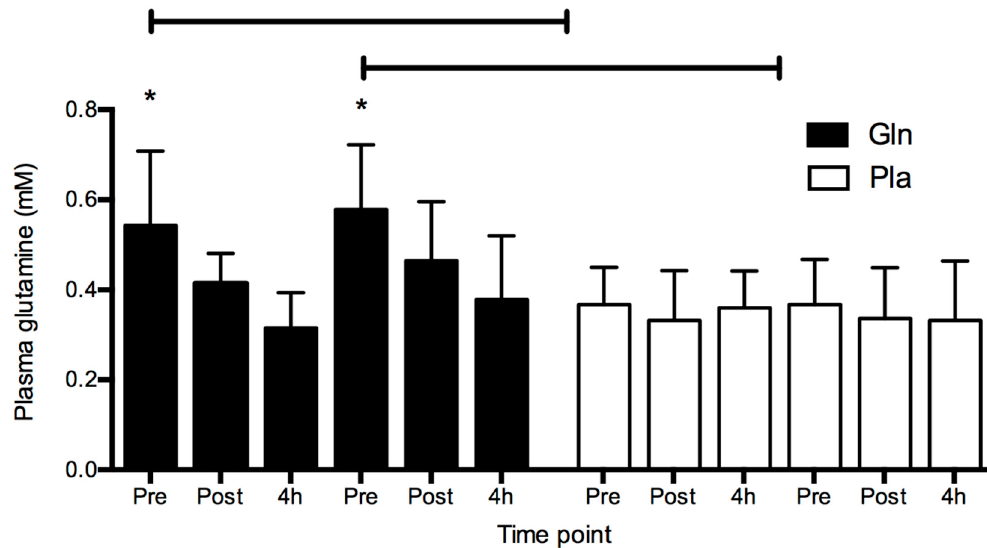
Figure 2. Plasma glutamine levels. Subjects ingested 0.075 g/kg of glutamine (Gln) or placebo (Pla) 1 hour prior to and after repeated exercise on consecutive days (Ex 1 = Day 1 and Ex 2 = Day 2). Plasma glutamine levels were measured pre, post, and 4 h post on consecutive days. Glutamine levels